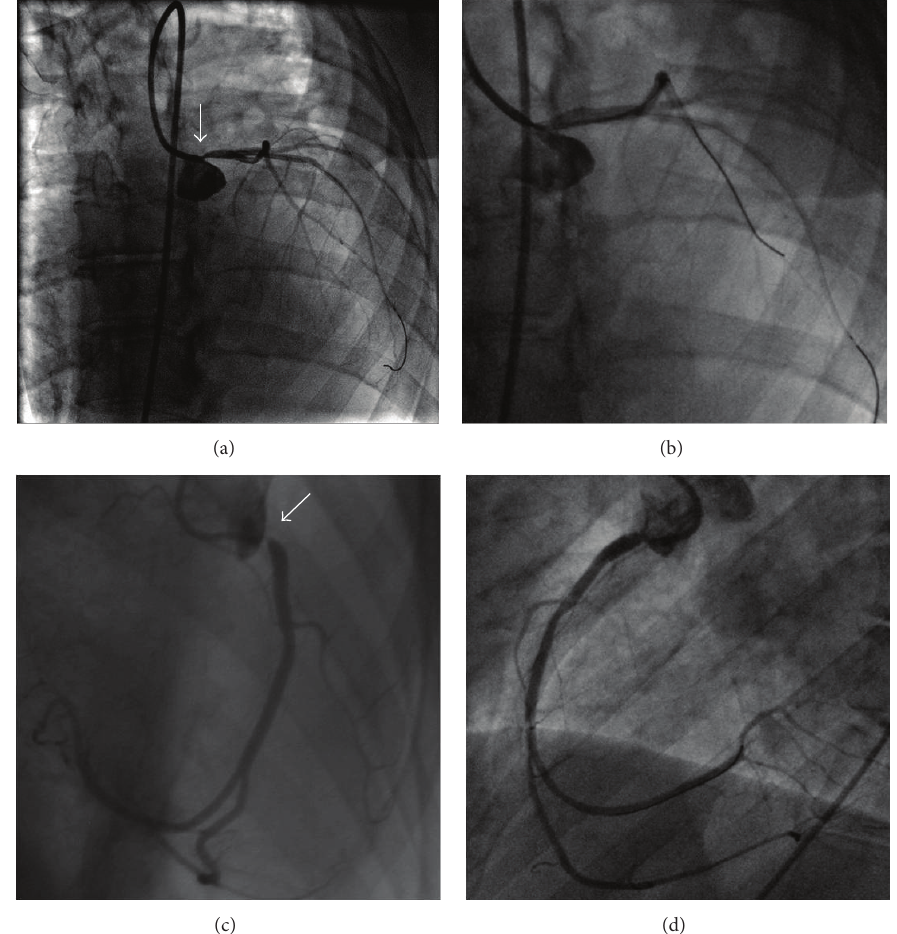
Figure 2: (a) Left coronary artery showing critical ostial left main stenosis (arrow). (b) Final result of the left main direct stenting with everolimus eluting stent. (c) Tight ostial lesion of the right coronary artery (RCA; arrow). (d) Final result after direct stenting of ostial RCA with sirolimus eluting